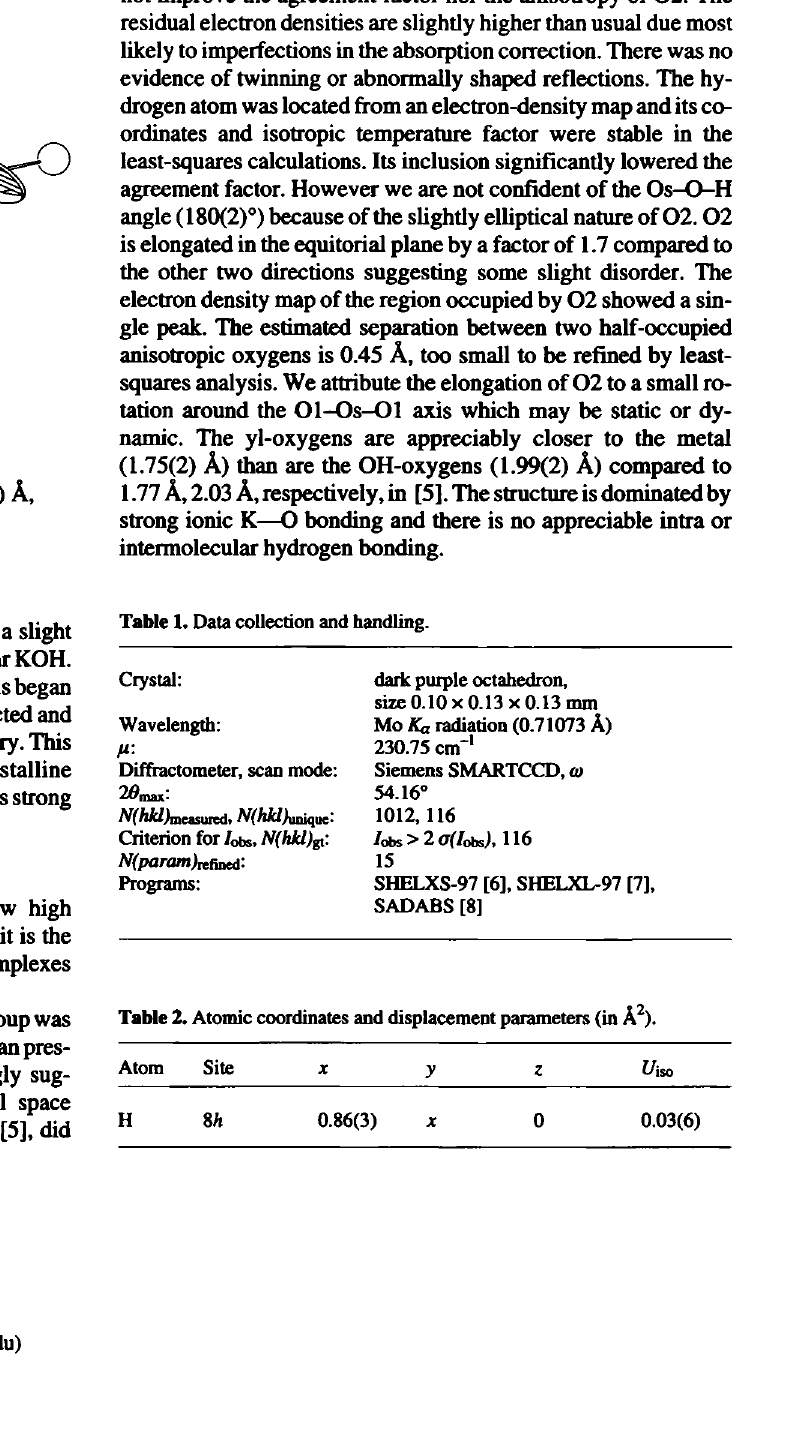
Table 2. Atomic coordinates and displacement parameters (in Â 2